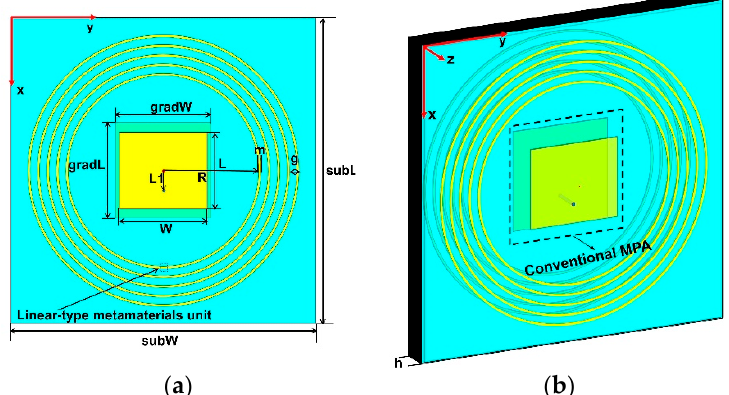
Figure 2. Schematic diagram of the MPA loaded with linear-type NPMMs. The blue part is the PTFE substrate, the central yellow part is the conventional MPA. Five concentric rings are formed by linear-type metamaterials units. ( a ) Top view; ( b ) side view.